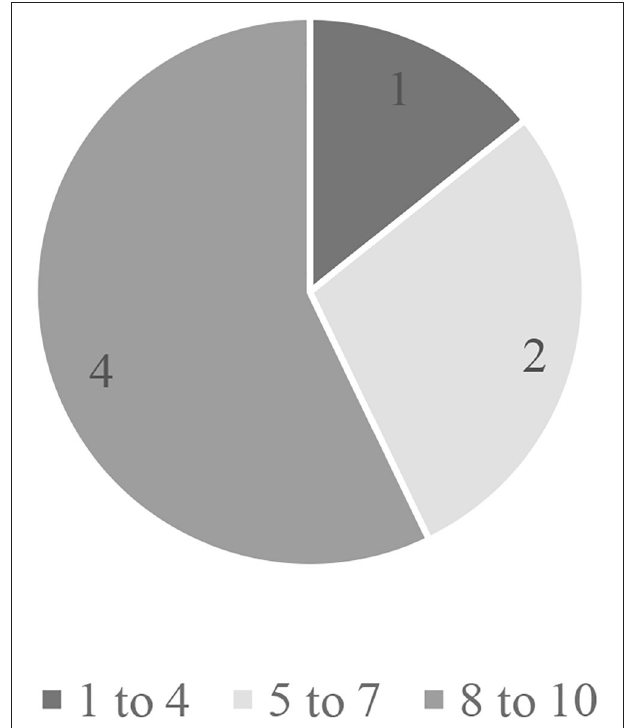
FIGURE 4 | Number of food companies in three score categories (1–4, 5–7, and 8–10, where 10 is the maximum score) illustrating how useful it would be for their company to be able to select from animal welfare schemes which are members of an alliance of higher welfare